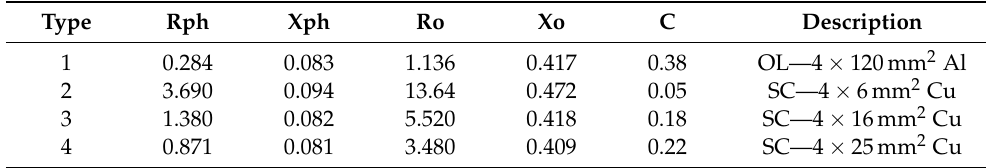
Table A1. Line types.